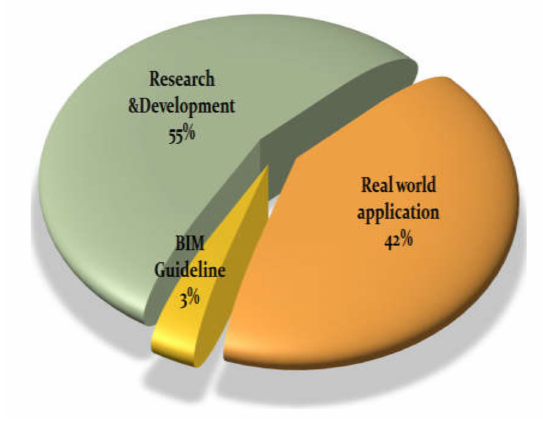
Figure 4. Use case type analysis.